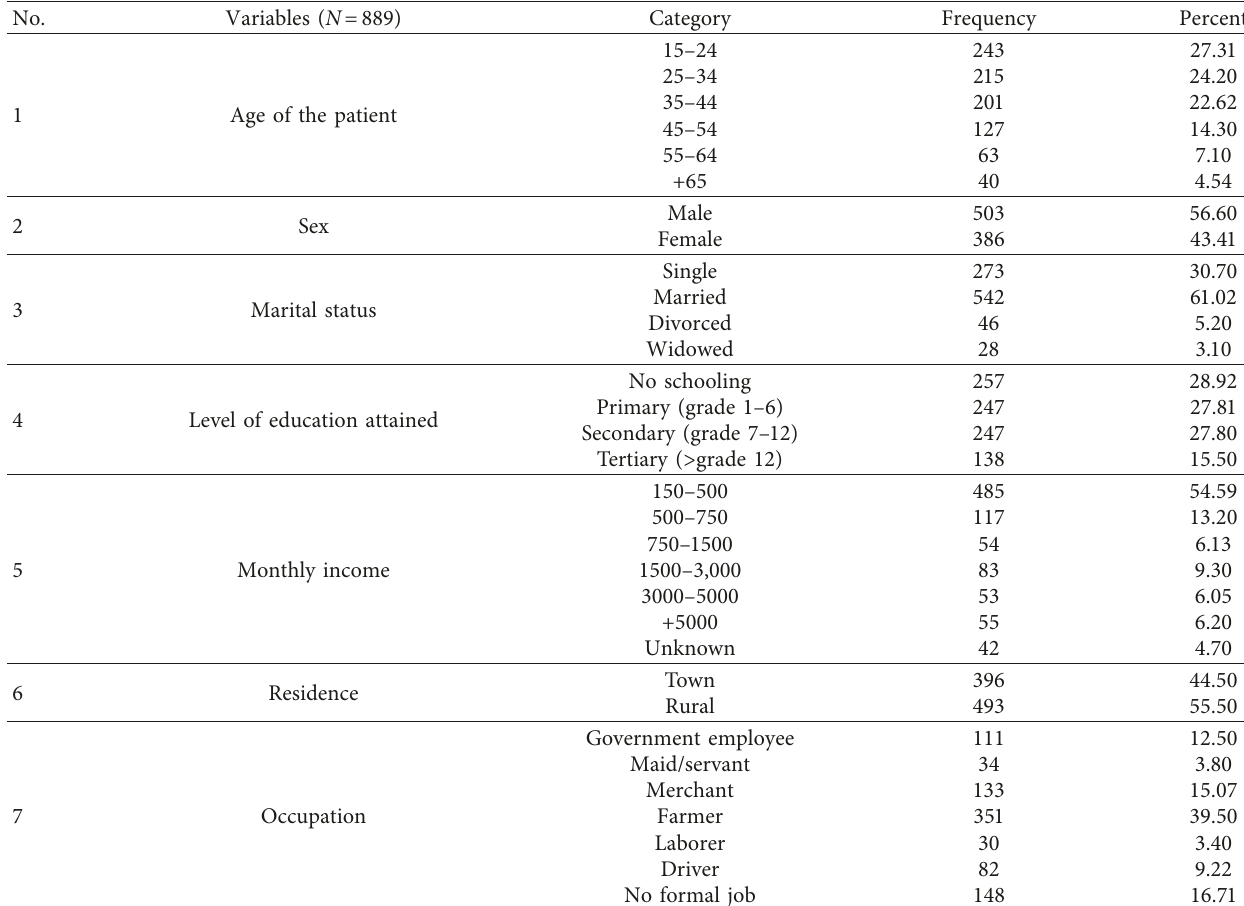
Table 1: Distribution of respondents by their socio-demographic characteristics in Nekemte, western Ethiopia, 2017. No.